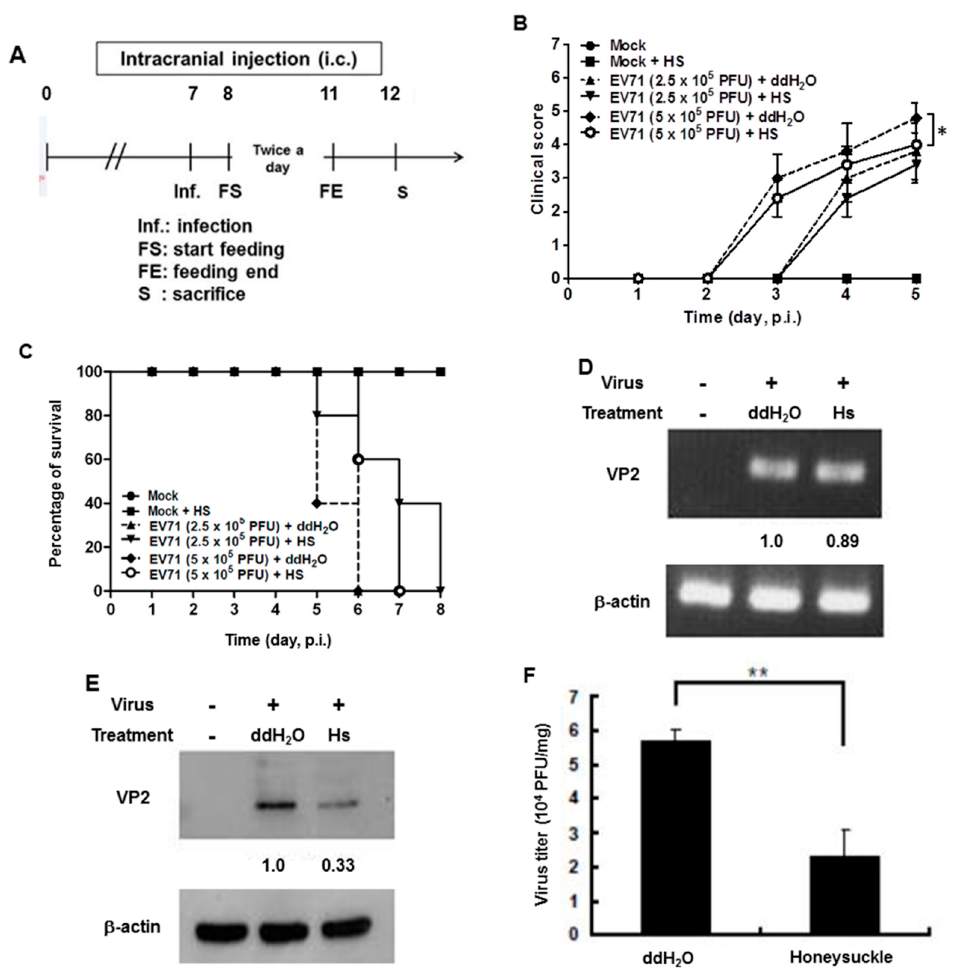
Figure 5. Honeysuckle treatment attenuated EV71/MP4 pathogenesis in infected ICR suckling mice. The 7-day-old ICR suckling mice ( n = 5, each group) were infected with either a mock infection (2% FBS in DMEM) or EV71 MP4 by intracranial injection followed by treatment with honeysuckle aqueous extract twice a day for four consecutive days. Mice that received boiled distilled water served as the Mock control. The mice were then examined for survival rate, disease symptoms and the viral gene expression and production in the brain. ( A ) The time schedule of suckling mice with the virus infection, honeysuckle treatment and sacrifice. ( B ) The mice were intracranially inoculated (IC) with two concentrations of EV71/MP4 followed by honeysuckle treatment. The clinical scores were measured from day 1 to day 5 PI. ( C ) The survival time of the EV71/MP4 infected mice with or without honeysuckle treatment was evaluated for eight days after infection. The virus-infected suckling mice were sacrificed at day 5 PI. Viral activities in the brain specimens were investigated. ( D ) The EV71/MP4 RNA level in brains was determined by RT-PCR. β -actin was used as the internal control. ( E ) The EV71/MP4 VP2 protein level in the infected suckling mice brains was determined by Western blotting using specific antibodies. β -actin was used as the internal control. ( F ) The viral titer of EV71/MP4 in the infected suckling mice brains was determined by plaque assay. HS: honeysuckle; ddH 2 O: double distilled water; N = the number of mice in each group. Mean ±